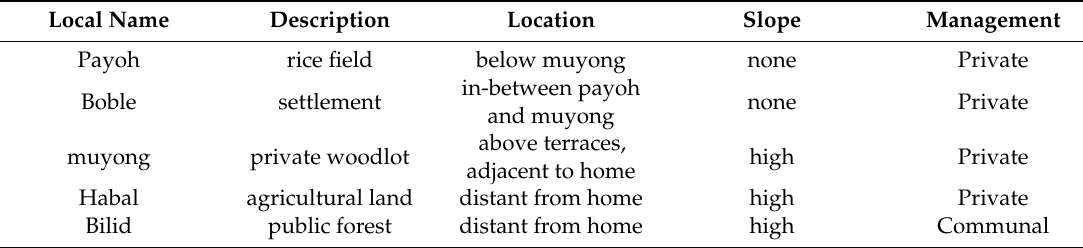
Table 1. Land use classes in